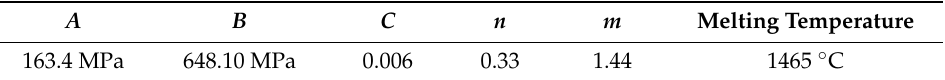
Table 3. Material properties of Ni 200 alloy [33].